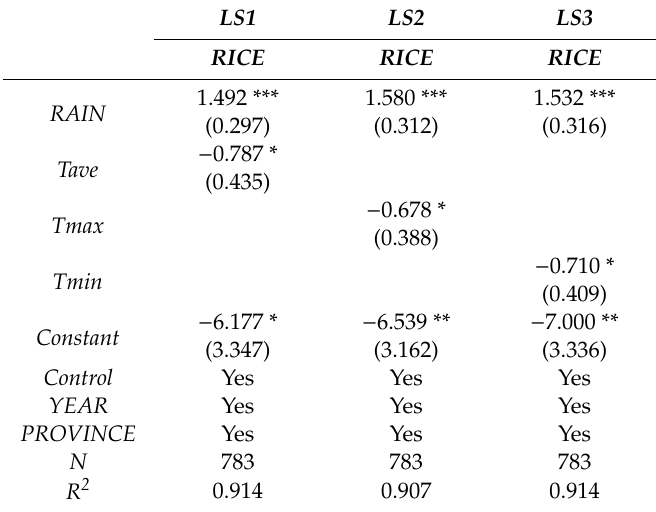
Table 2. The regression results for the direct e ff ect.